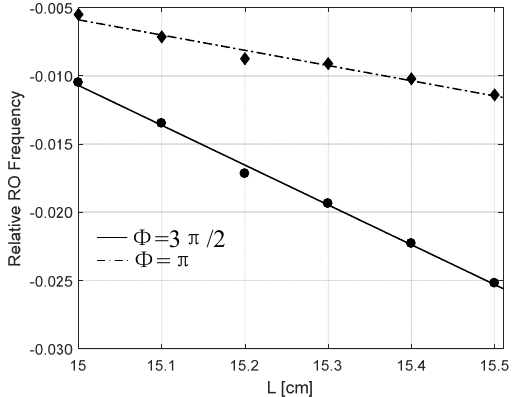
Figure 10. Fitting curves of RO frequency for α measurement (adapted from [65]).